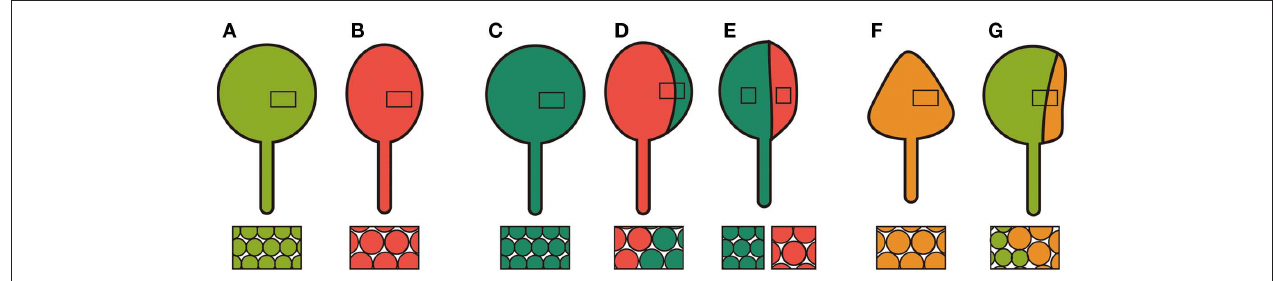
FiGuRE 1 | Schematic diagram of chimeric leaves and cell size. (A) A wild-type leaf. (B) An an3 leaf with cells larger than wild-type. (C) An AN3